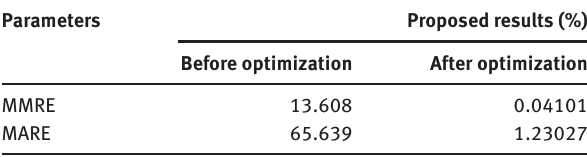
Table 3: Parameter Values Before and After Applying the ABC Algorithm for the Optimization for the Desharnais Dataset. Parameters Proposed results